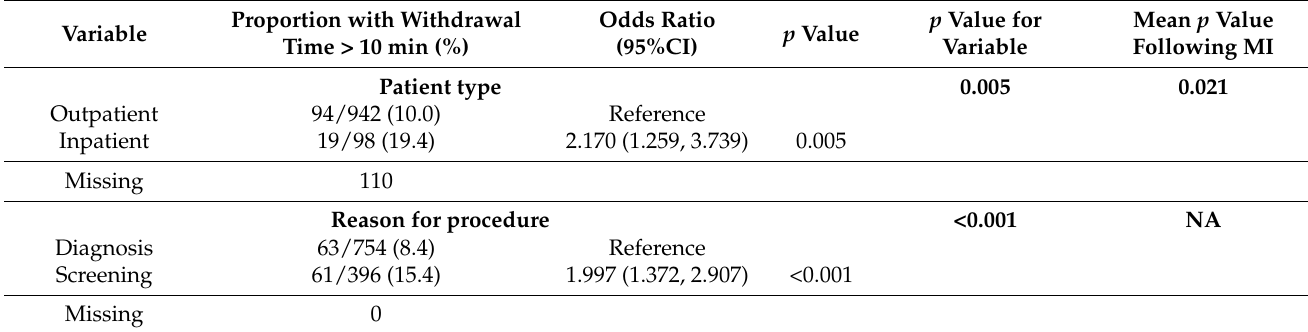
Table 2. Influence of individual variables on the proportion of patients with a withdrawal time greater than 10